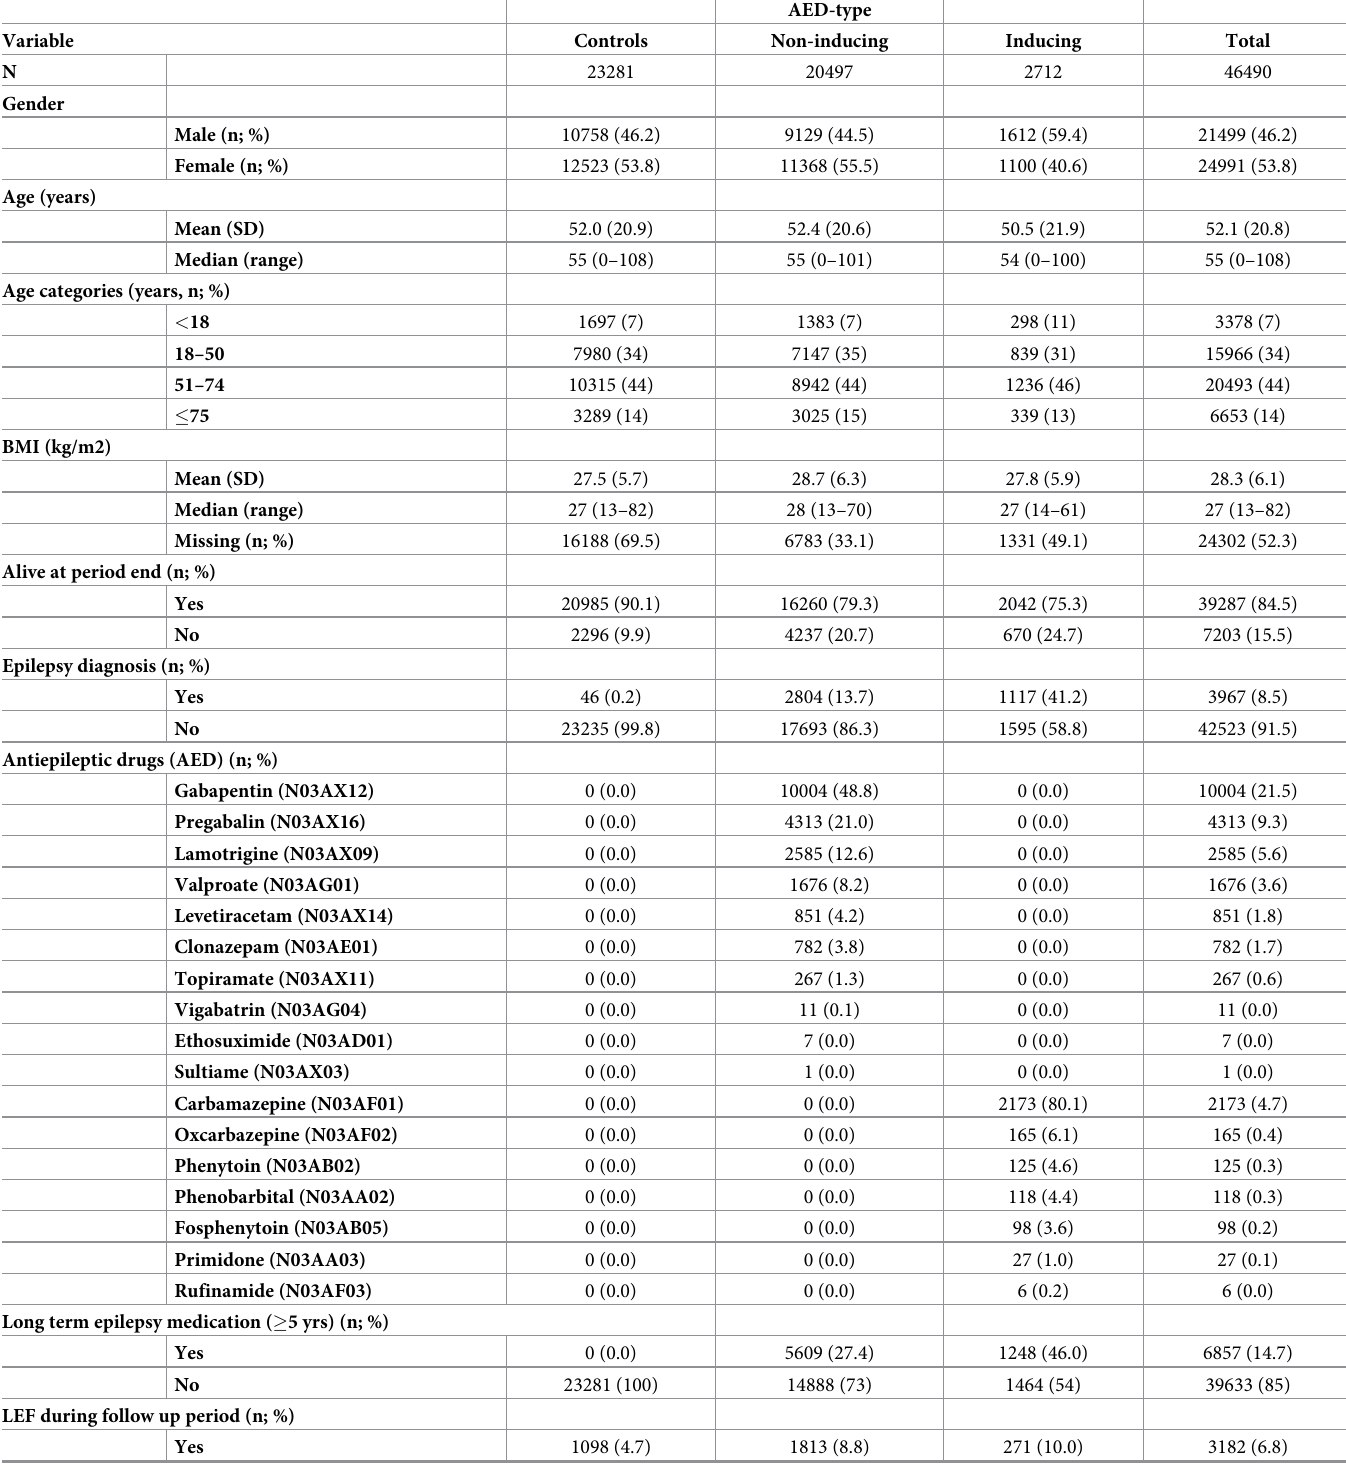
Table 1. Characteristics of patients prescribed antiepileptic drugs according to enzyme inhibiting profile and age- and gender-matched